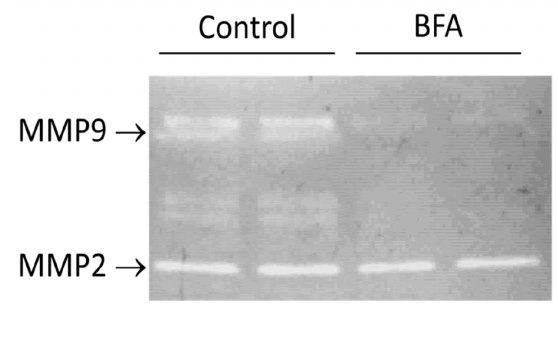
Figure 6. The effect of BFA on the activity of MMPs in Colo 205 cells. Colo 205 adhesion cells were treated with or without 0.015 μ g/mL BFA for 24 h. The media were then collected and the MMP activity was analyzed by gelatin zymography assay. Results from duplicate experiments are